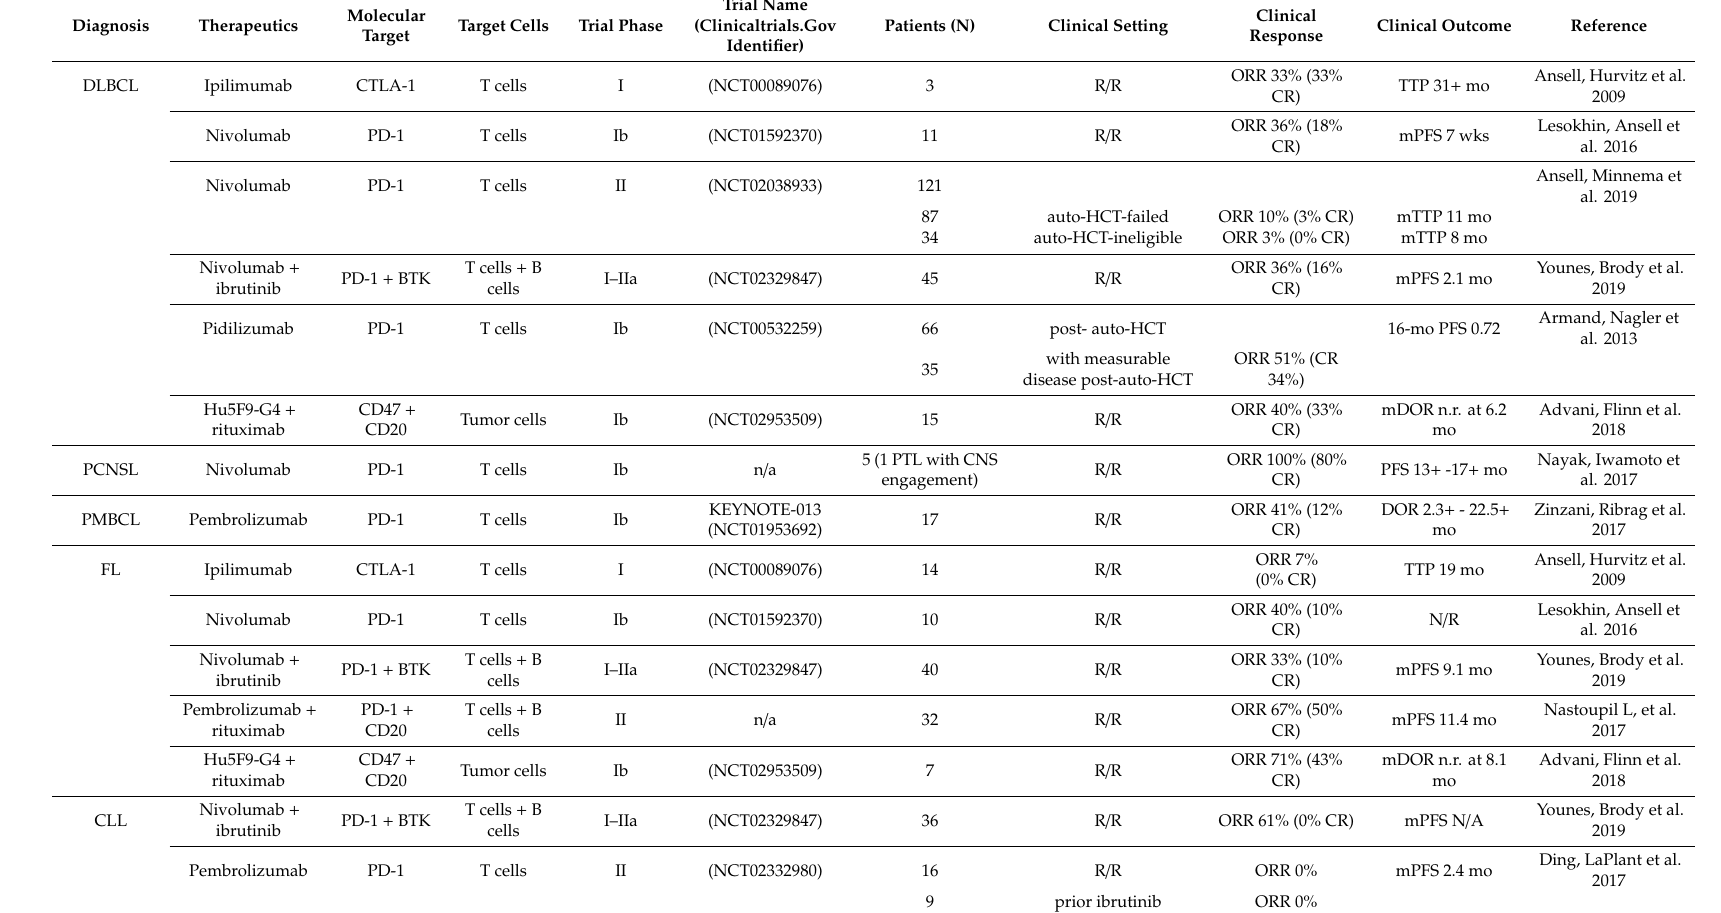
Table 2. Published clinical trials with therapeutics targeting the immune tumor